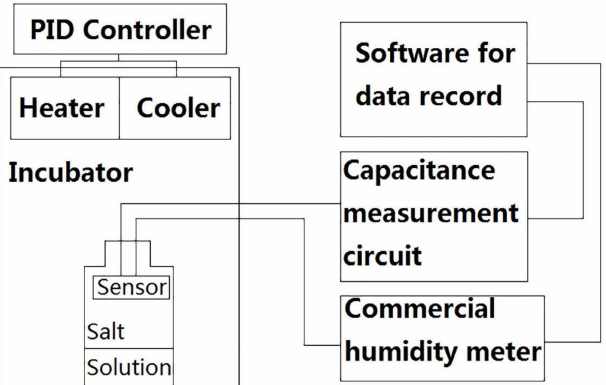
Figure 6. Block diagram of the measurement system consisting of an incubator, a measurement circuit and recording software.